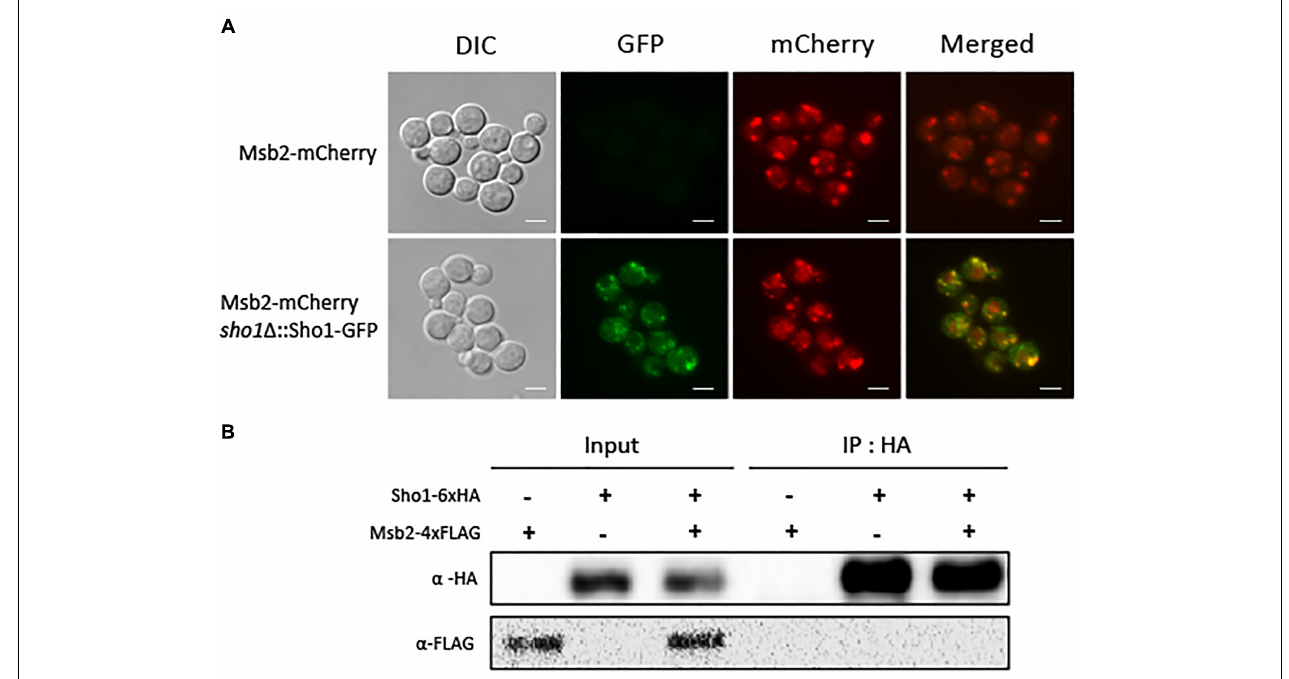
FIGURE 4 | Both Sho1 and Msb2 proteins appeared to be localized to the cell periphery, but Sho1 and Msb2 did not physically interact with each other. (A) To determine the localization of Sho1 and Msb2, the sho1 (cid:49) ::SHO1-GFP (YSB2753), MSB2-mCherry (YSB4128), and sho1 (cid:49) ::SHO1-GFP MSB2-mCherry (YSB4132) strains were grown overnight at 30 ◦ C in liquid YPD medium. The cells were fixed and visualized by fluorescence microscopy. Scale bar, 10 µ m. (B) The Sho1-6 × HA protein was immunoprecipitated with an anti-HA antibody (IP: α -HA), and the Msb2-4 × FLAG protein was detected by immunoblotting with an anti-FLAG antibody (IB: α -FLAG). This experiment was repeated twice and one representative result was shown